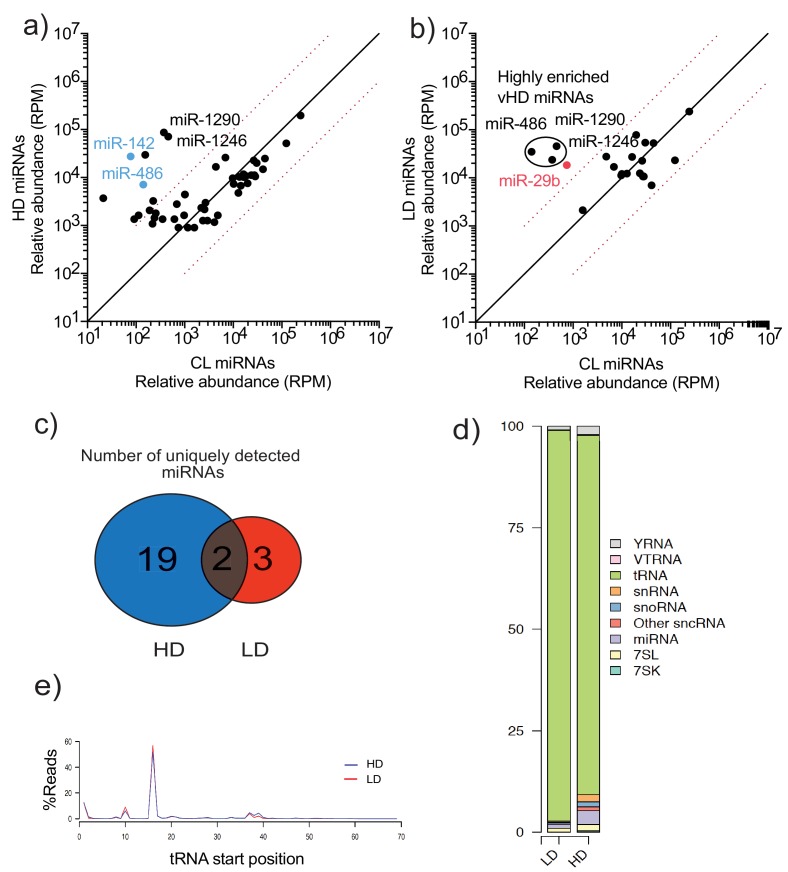
TGIRT-sequencing of high buoyant density and low buoyant density sEV sub-populations.(a, b) Scatterplots showing the relative abundance (as reads per million (RPM)) for miRNAs detected in vHD and vLD sub-populations relative to CL levels. Normalized per total number of miRNA reads. In blue, vHD miRNAs that were selected for further validation by qPCR. In red, vLD miRNAs selected for further validation by qPCR. Circled miRNAs in vLD represent those also found to be enriched in the vHD-subpopulation c) Venn Diagram showing the total number of vHD and vLD uniquely found miRNAs (miRNAs with non-detectable signal in cellular lysates) detected by TGIRT-seq. (d) Bar graph showing the distribution of all small non-coding RNA transcripts found in vHD and vLD sub-populations. (e) tRNA start site distribution showing the majority of tRNA reads start at position 16, previously described as the site of an EV-specific D-loop modification (Shurtleff et al., 2017). The putative D-loop modification is present at relatively same levels in both the vHD and vLD sub-populations. CL: cellular lysate. Dashed red lines in a and b represent 10-fold differences.